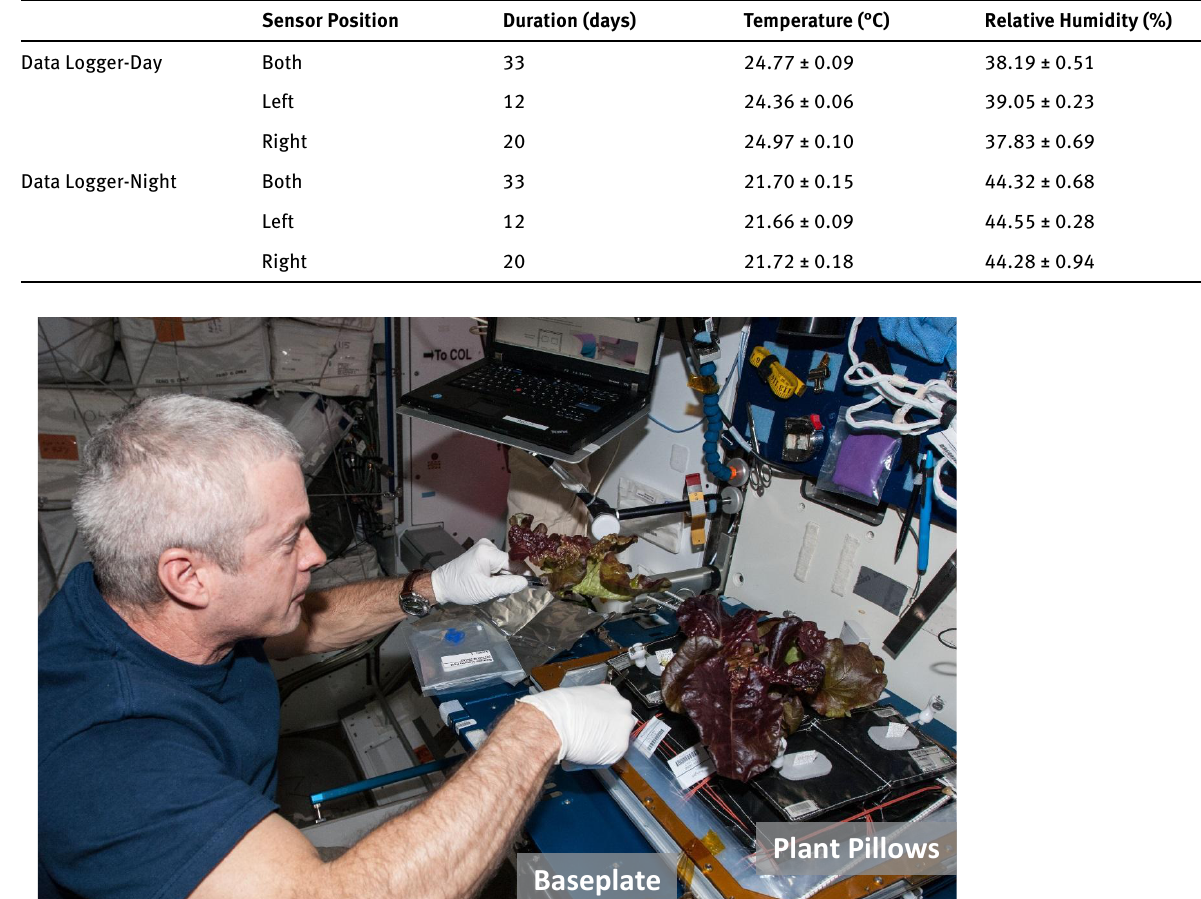
Table 2. Environmental data collected from within the Veggie hardware during VEG-01A. Data points are averages ± standard deviations for sitions were instantaneous, but for calculation simplicity to avoid the photoperiod transition period, night data are averages of the hours between midnight and 05:45 AM and day data are averaged between 10:00 AM and 15:45 PM to give 24 data points for each period. On day 13 following initiation the data logger was shifted from the back left corner to the back right corner of the hardware. Average data from each side are displayed with the day of shifting omitted from calculations